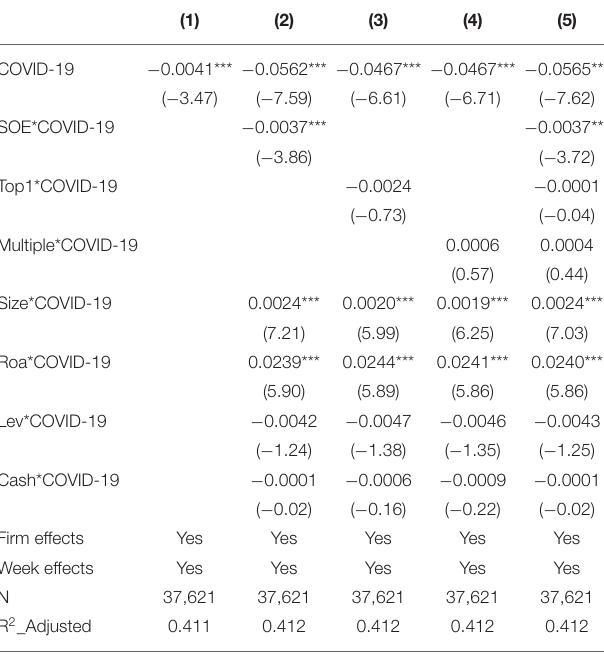
TABLE 2 | Ownership structure and stock price reactions. TABLE 3 | Board structure and stock returns in response to